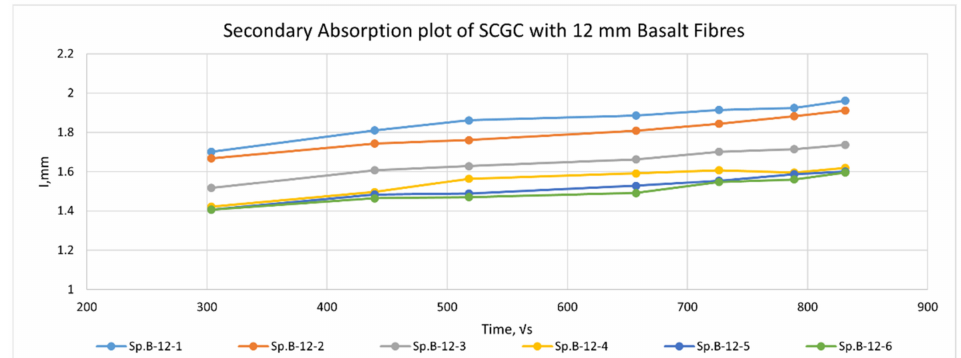
Figure 8. Secondary absorption plot of SCGC with 12 mm basalt fibres.